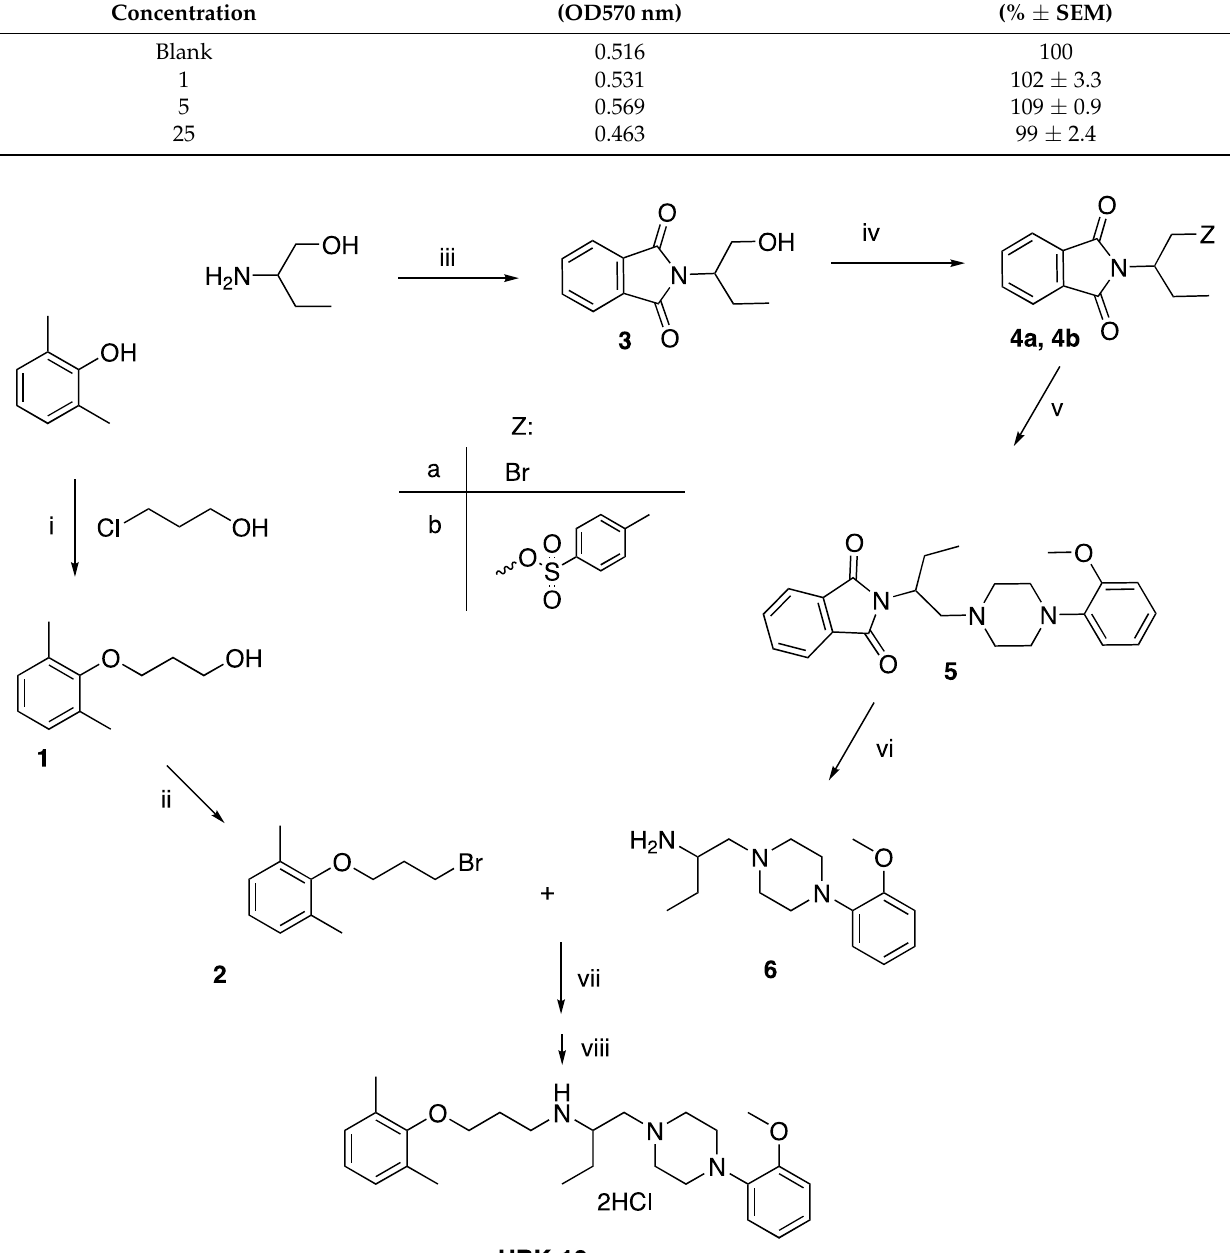
Table 1. Viability of HepG2 cells incubated with HBK-10 in concentration 1–25 µM for 24 h. HBK-10